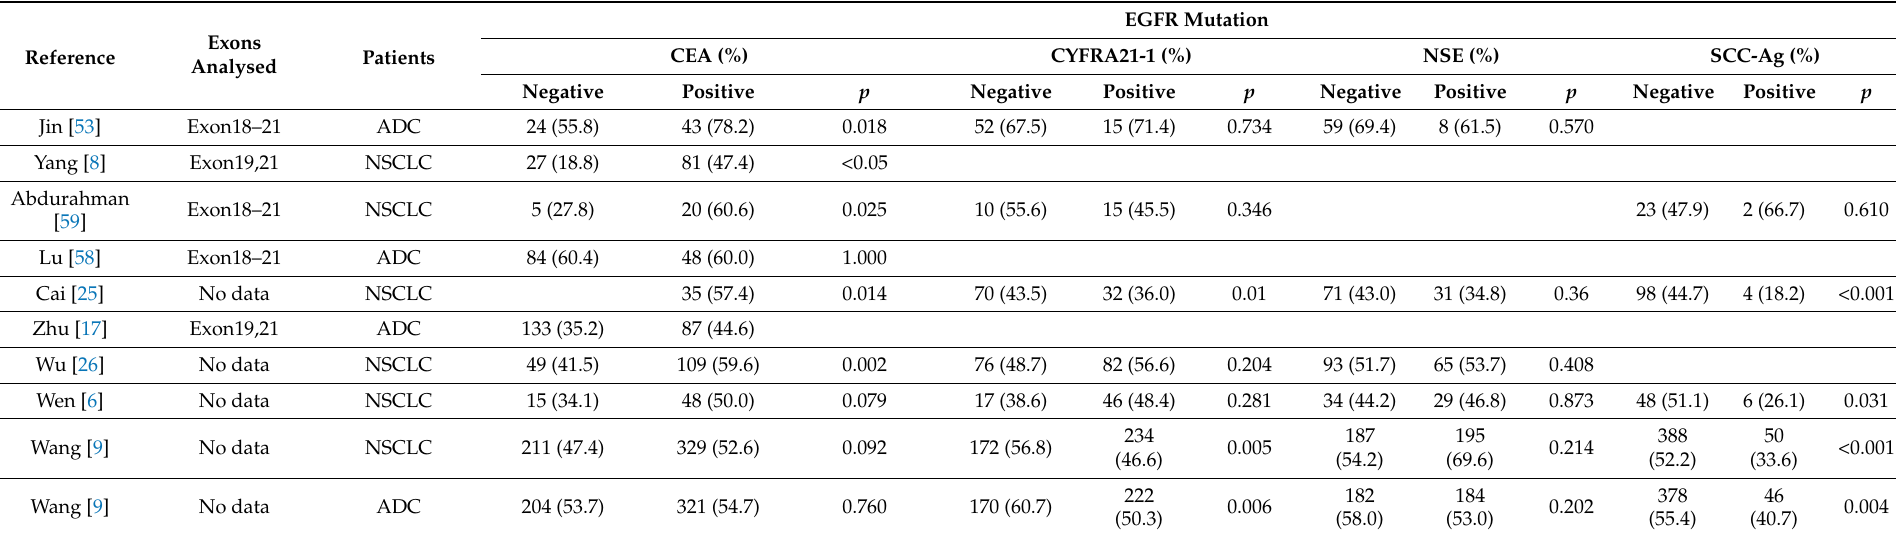
Table 2. Key studies of serum tumor markers and EGFR mutation rates of NSCLC patients in East